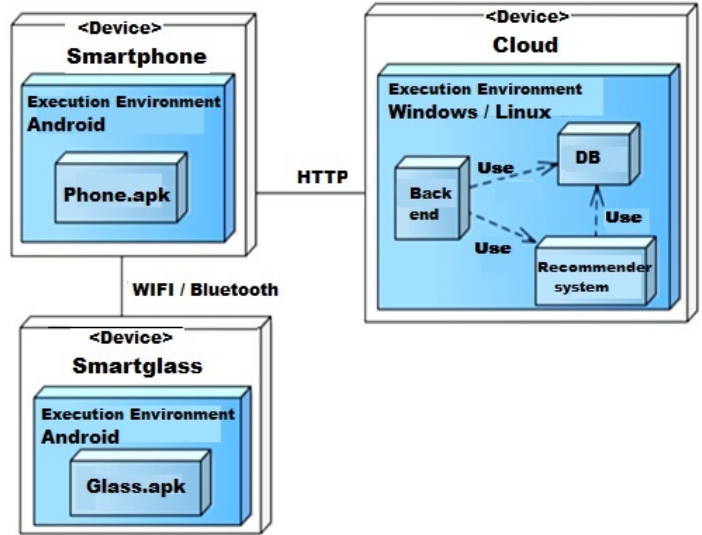
Figure 11. IIoTMS deployment